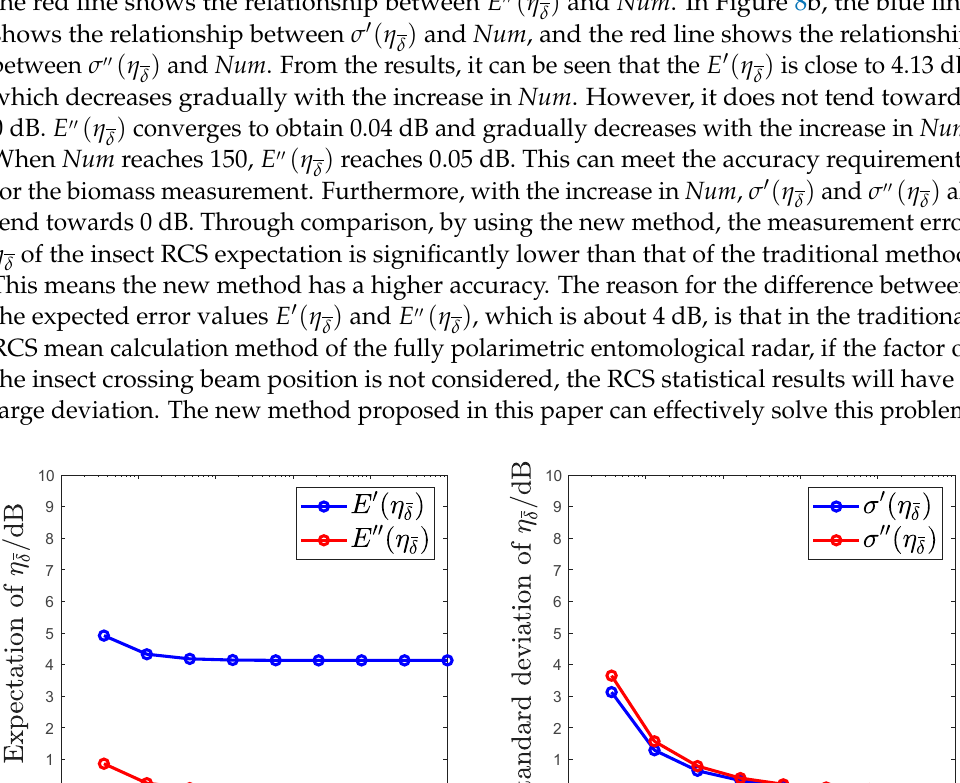
: ( a ) expectation of η ; ( b ) standard deviation of η δ δ